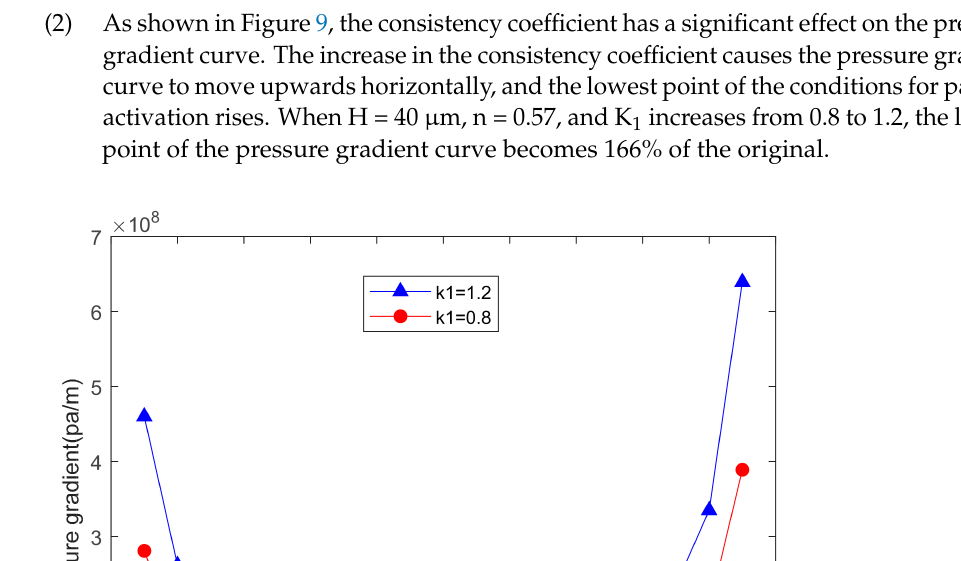
Figure 8. Pressure gradient curve under the influence of fluidity index.